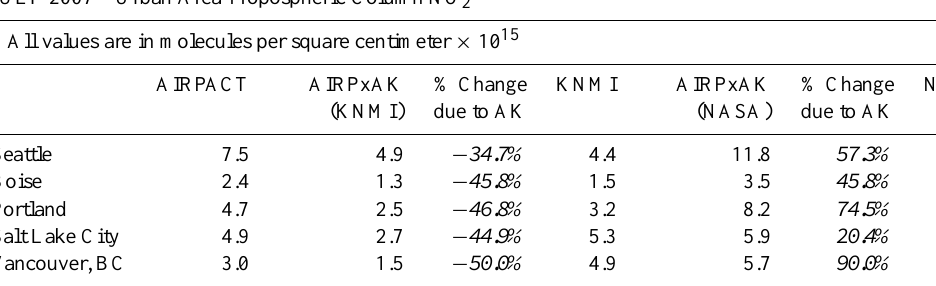
Table 4. Differences in average tropospheric NO 2 for urban areas as a result of applying the averaging kernels from KNMI and NASA. Summer (July 2007) and winter (January 2008) monthly averages are shown. KNMI and NASA columns are provided as well for reference. JULY 2007 – Urban Area Tropospheric Column NO 2 ∗ ∗ All values are in molecules per square centimeter × 10